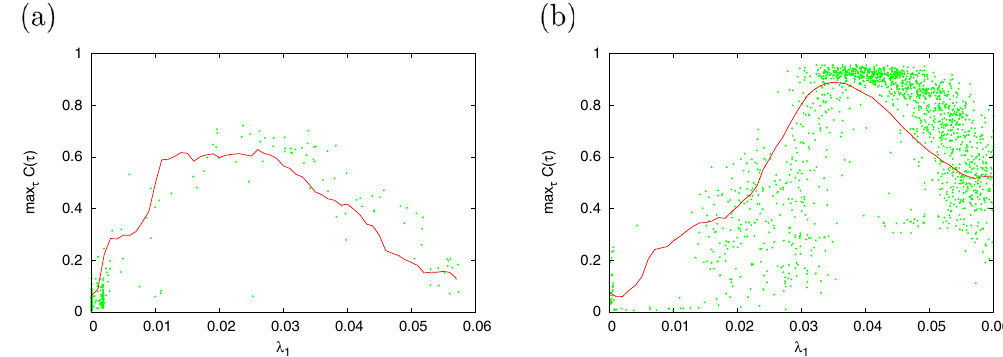
Figure 4. Scatter plot between max τ C ( τ ) and λ 1 obtained in Fig. 3 (red dotted line: mean value of max τ C ( τ ) in bin λ 1 with window Δ λ 1 = 0.001). Signal response in CR has a unimodal maximum with respect to the stability for chaotic orbits represented by λ 1 , ( a ) Region #1. ( b ) Region #2.